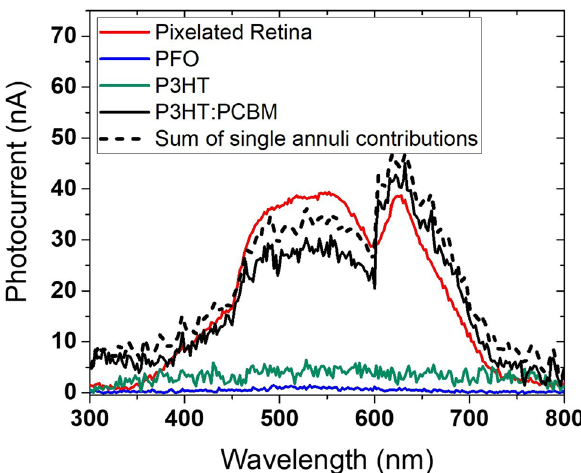
Figure 6. Spectral responsivity of the inkjet-printed artificial retina. Photocurrent measured from the pixelated retina compared to the photocurrent calculated as the weighted linear summation of the single polymer-annuli contributions. I ph originating from singular annuli were recorded by using a monochromator/lock-in set up and additional customized shadow masks so as to illuminate only the polymer annulus of interest by covering the remaining part of the printed artificial retina. (OriginPro 2016 was